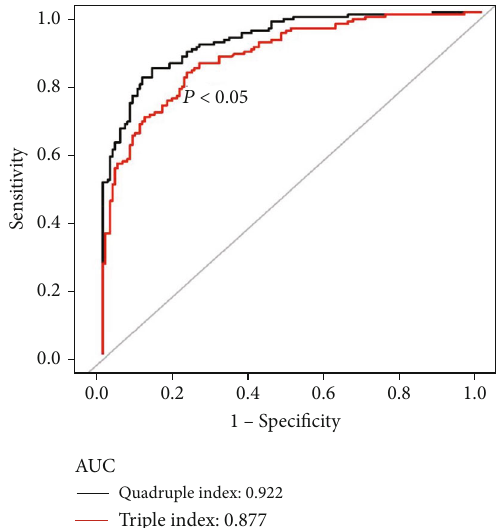
Figure 4: Comparison of the ROC curves of quadruple index and triple index for the prognostic value of 28-day mortality in patients with sepsis. ROC: receiver operating characteristic; AUC: area under the curve; APACHE II: Acute Physiology and Chronic Health Evaluation; AFR: albumin-to- fi brinogen ratio; triple index includes APACHE II score, lactic acid, and septic shock; quadruple index includes APACHE II score, lactic acid, septic shock, and